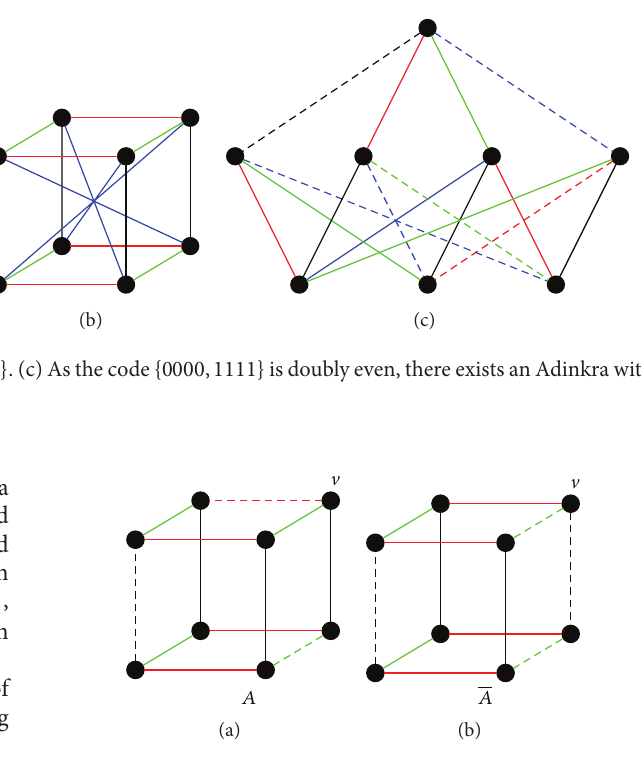
Figure 3: A vertex switching at V turns the Adinkra 𝐴 on the left into the Adinkra 𝐴 on the right. The two Adinkras have the same dashing except precisely the edges that are incident to V . Note that in both cases each face of the cube has an odd number of dashed